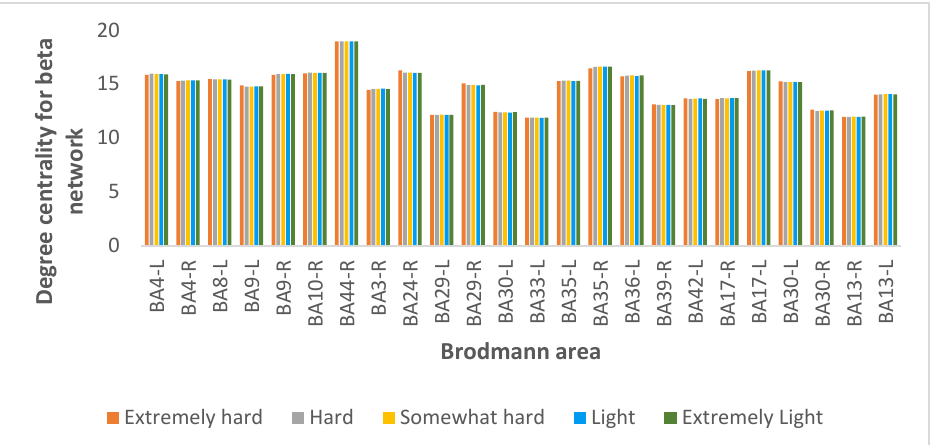
Figure 16. Results for degree centrality for the beta coherence network at exertion levels extremely hard (orange), hard (gray), somewhat hard (yellow), light (blue), and extremely light (green). Nodal Efficiency